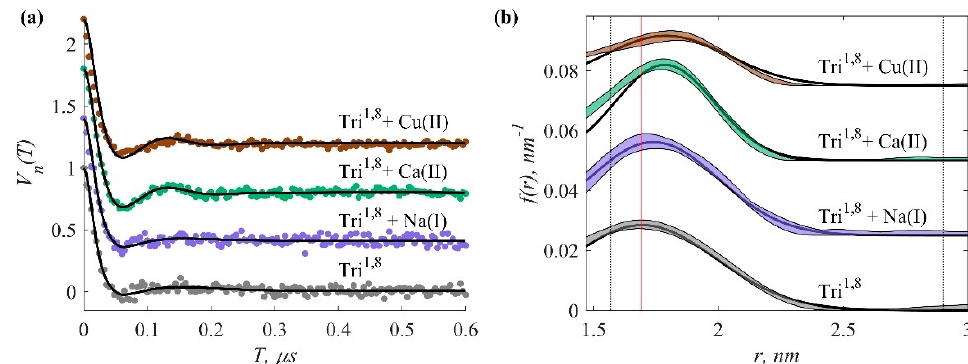
Figure 3. ( a ) Normalized DEER traces for Tri 1,8 with or without metal ions. Colored circles, experimental data; black curves, the best fit. Traces are shifted up for clarity. ( b ) Distance distribution functions between spin labels in the peptide with or without metal ions, evaluated by DeerAnalysis (shaded areas show the confidence interval derived from data validation. Parameters and their variation boundaries are reported in paragraph 2.3), and its fit by an unimodal Gaussian distribution (black curves). Vertical, dashed lines limit the distance range unperturbed by truncation and sampling noises; the red line is at the mean TOAC-TOAC distance for Tri 1,8 without metal ions. Distributions are shifted up for clarity. Color code of the systems is the same in both panels. Table 1. Parameters of the Gaussian distribution between spin labels ( f(r) = 1/( √2𝜋𝛿𝑟 (cid:2870) )• exp(-(r- <r>) 2 /2 δ r 2 ) , with related standard deviations. <r> , mean distance between labels; δ r , dispersion of the related distribution.